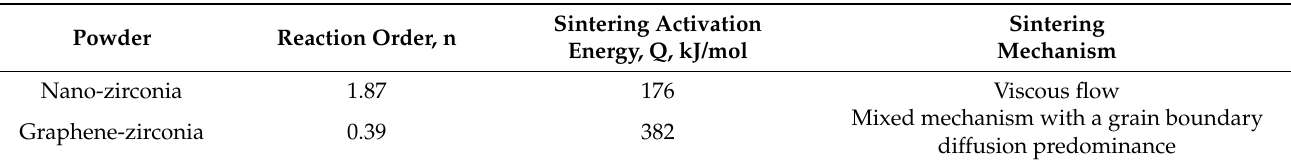
Figure 11. Schematic image of the van der Waals interaction between the graphene sheets and the zirconia nanocrystals in the composite nanopowder. Table 2. Parameters and mechanisms of the sintering of the nanostructured zirconia and the graphene-containing composite based on it.